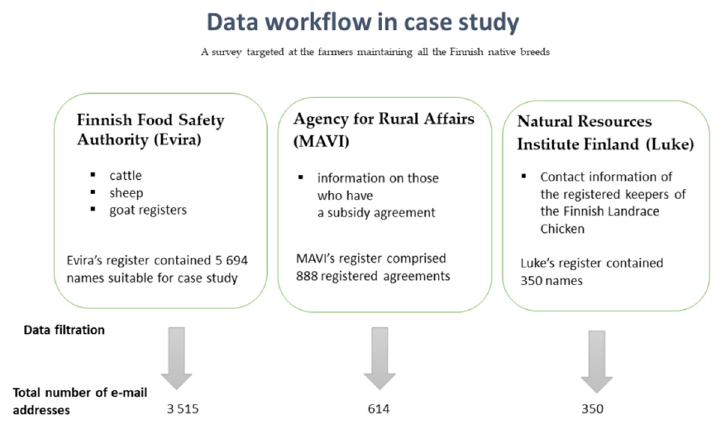
Figure 1. Data workflow in the case study. The figure demonstrates the utilisation of multiple registers to comprehensively reach the stakeholders keeping indigenous breeds. Notice that the Finnish Food Safety Authority (Evira) and Agency for Rural Affairs (MAVI) merged in 2019 and formed the current Finnish Food Authority.